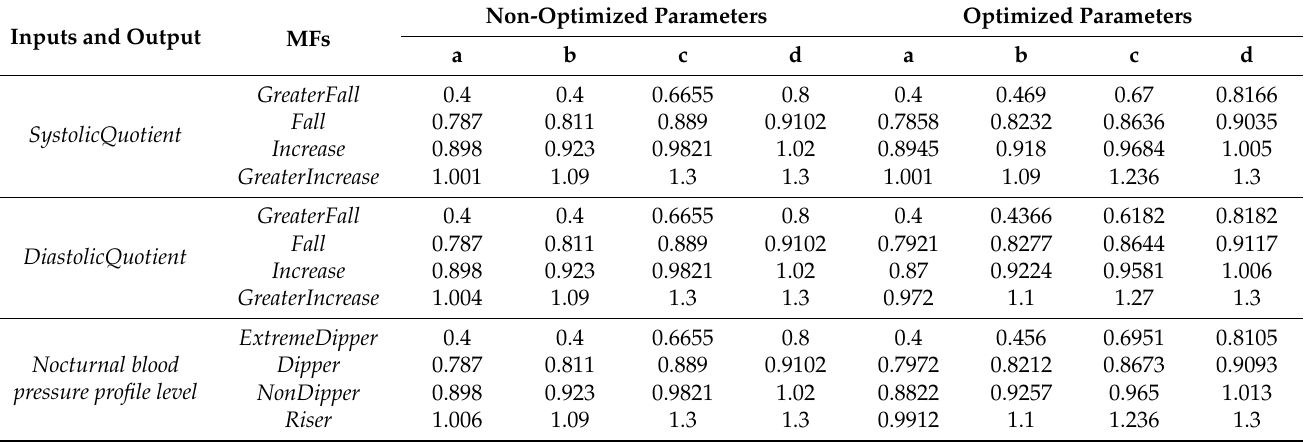
Table 11. Parameters used for the nocturnal blood pressure classifier design with trapezoidal mem- bership